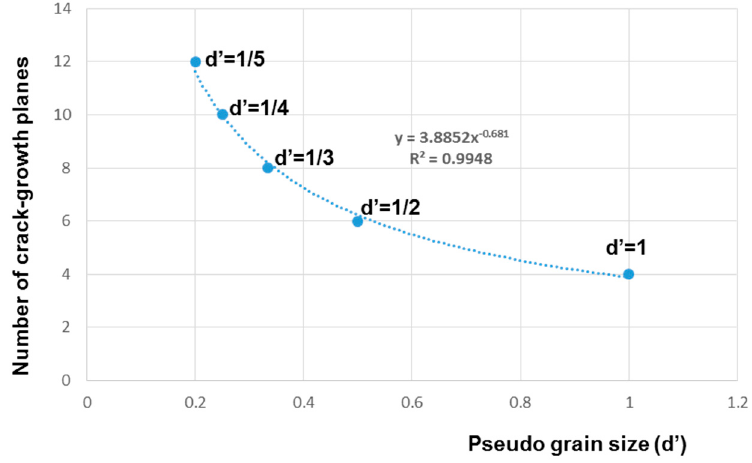
Figure 6. Relationship between pseudo grain size and the number of potential crack-growth planes.